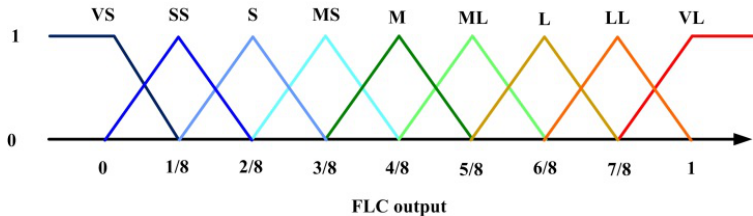
Figure 7. Output MF of of the proposed FLU.